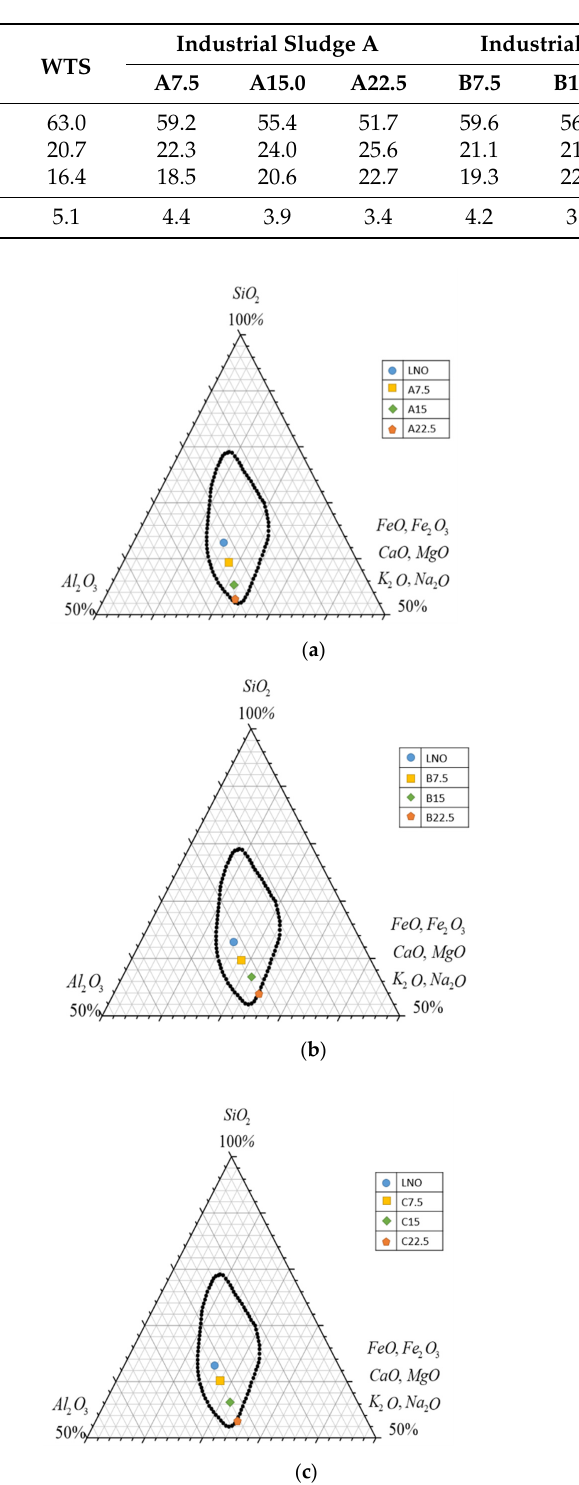
Table 5. The chemical component analysis of the (SiO 2 + Al 2 O 3 )/fluxing ratio (% by weight).